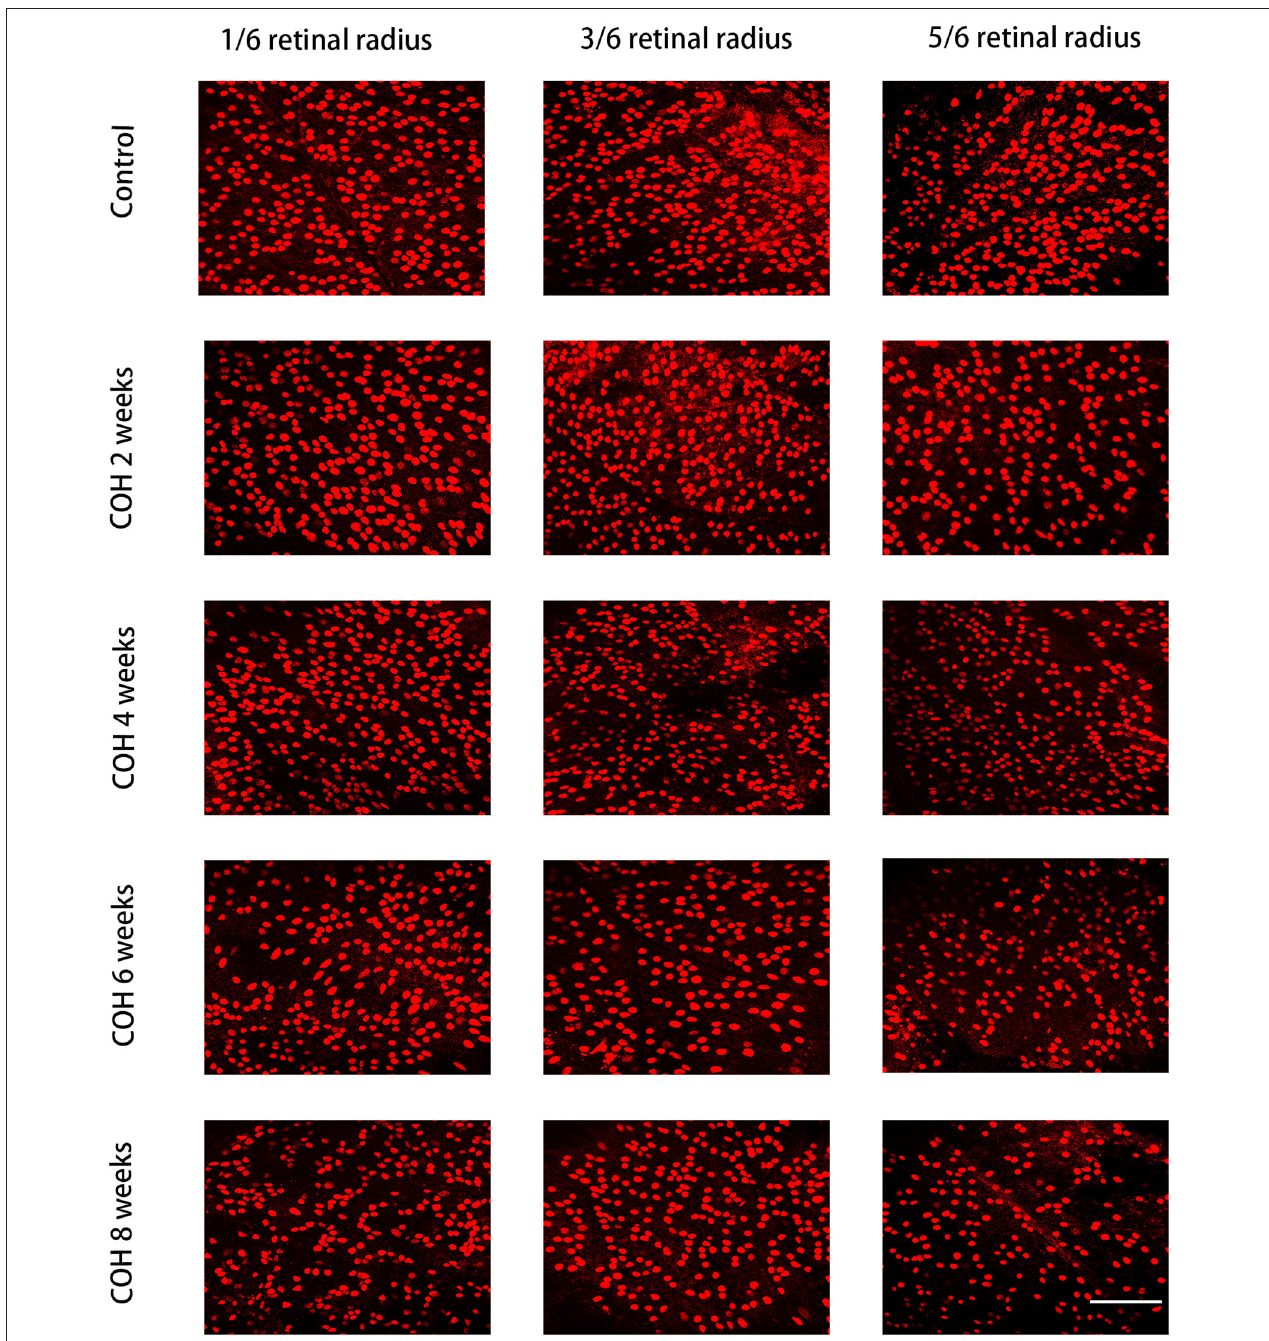
FIGURE 8 | Density of retinal ganglion cells (RGCs) in the control group and COH mice. The label of RGCs with Brn3a in 1/6, 3/6, and 5/6 retinal radius in mice at 2, 4, 6, and 8 weeks of COH (magnification × 200, scale bar = 50 µ m). N = 12 mice (control group: 3 mice; hydrogel injection group: 9 mice).